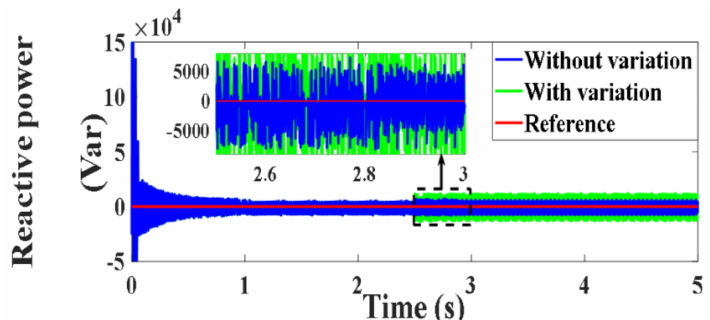
Figure 158. Reactive power under PVC (var).